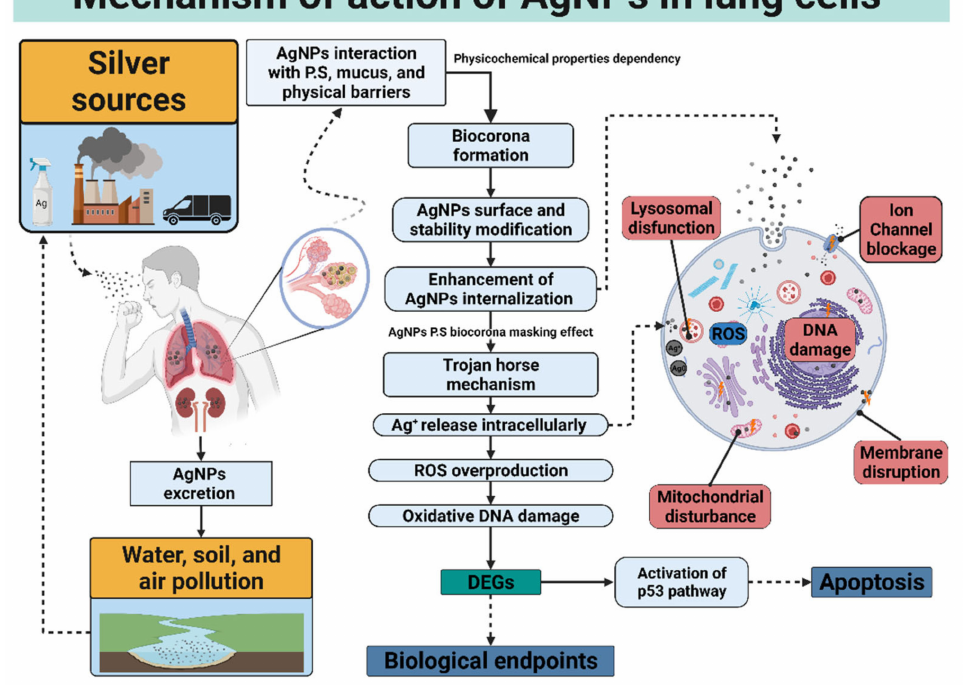
Figure 3. Continuous exposure to AgNPs or silver ions generates imminent bioaccumulation in major organs, specifically in the lungs. AgNPs will interact with the different biological components existing in the lungs, facilitating the formation of protein corona and biodistribution. Once inside, AgNPs exert a cytotoxic effect through a Trojan horse-type mechanism for uncoated or non-stable coating agents or a different mechanism when the coating agent is most stable or at a high concentration. It could generate ROS overproduction, transcriptional reprogramming, and apoptosis mediated mainly by the p53 pathway. This image summarizes the proposed cytotoxic mechanism of AgNPs within the